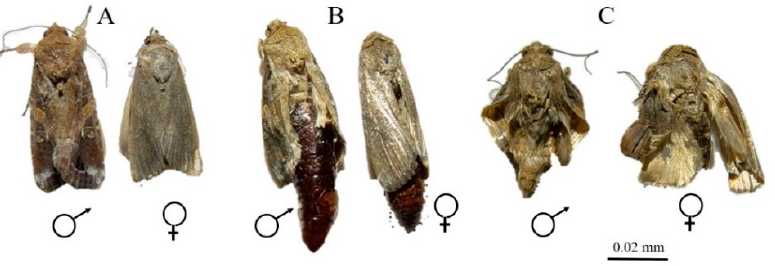
Figure 1. ( A ) Control male and female after emergence; ( B , C ) Malformed male and female after emergence.